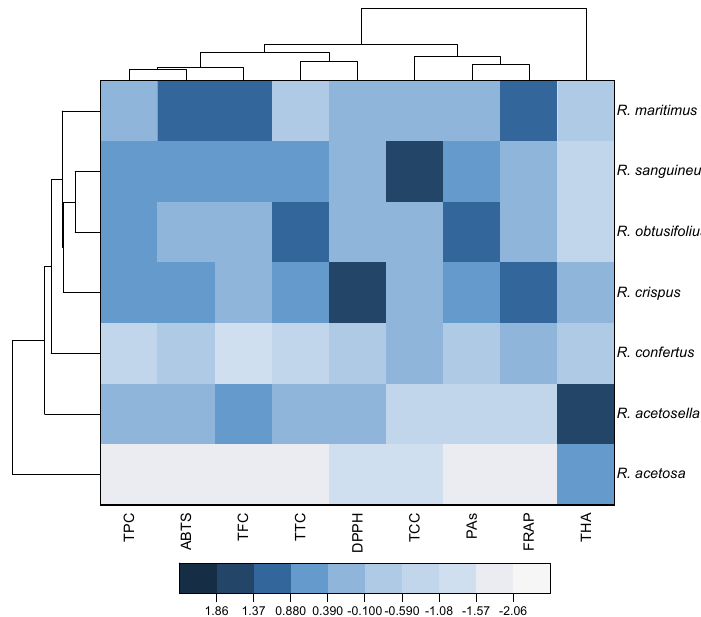
Figure 1. Heat map with clusters for studied variables (at the top) and Rumex species (at the left). TPC, total phenolics content; TFC, total flavonoids content; THA, total hydroxycinnamic acids; TCC, total catechins content; PAs, total proanthocyanidins content; TTC, total tannins content; DPPH, antioxidant activity determined by the DPPH (2,2-diphenyl-1-picrylhydrazyl) assay; ABTS, antioxidant activity determined by the ABTS (2,2 ′ -azino-bis(3-ethylbenzothiazoline-6-sulfonic acid)) assay; FRAP, ferric reducing antioxidant power.